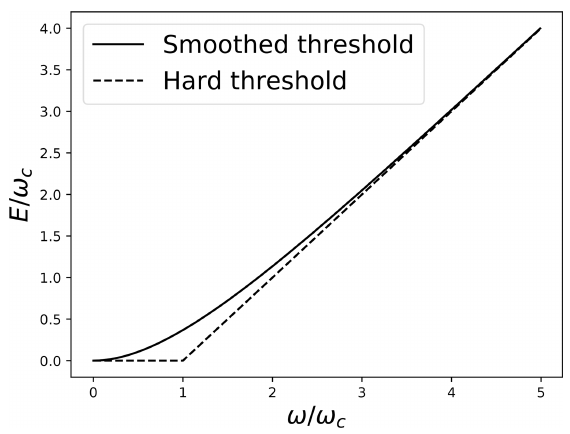
Figure 3. Illustration of the functional form of the smooth-threshold erosion law (Eq. 31) compared with the more traditional hard- threshold